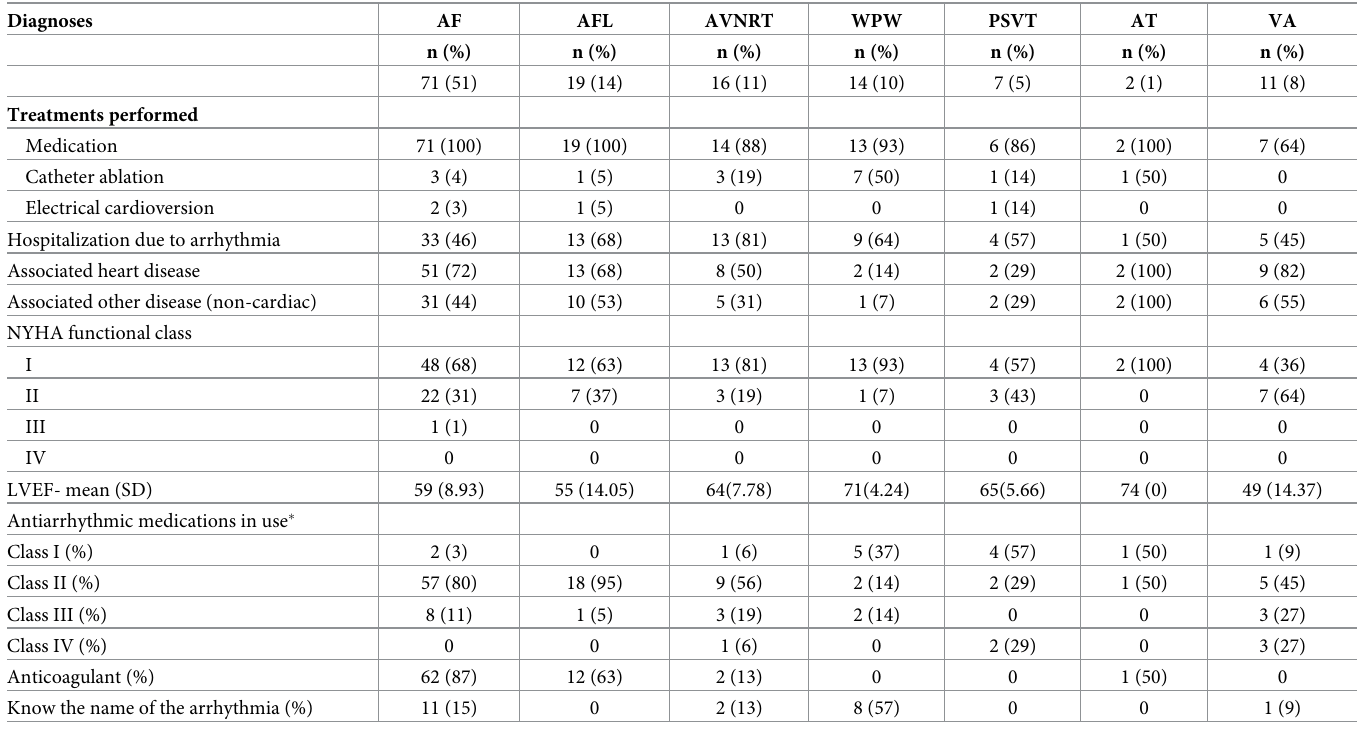
Table 3. Clinical characteristics of the participants (n =